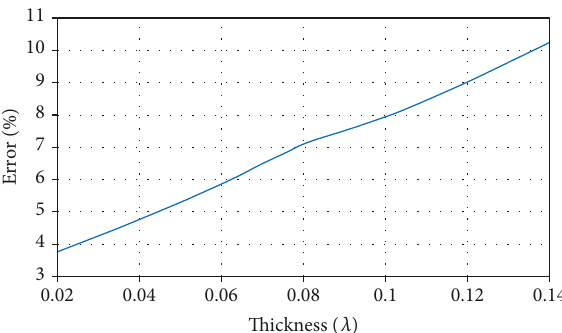
Figure 15: Phase of electric fi eld of the ϕ component in the ϕ =40 ° plane with w =4 λ and h =1 λ , at 4GHz compared with simulation result.